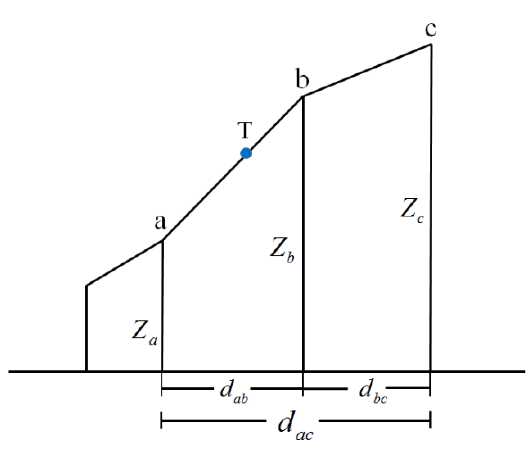
Figure 5. Estimation of M 2 at T using the contour line approach. a , b , and c are points on the contour lines of Z a , Z b , and Z c respectively. T is a point in between Z a and Z b